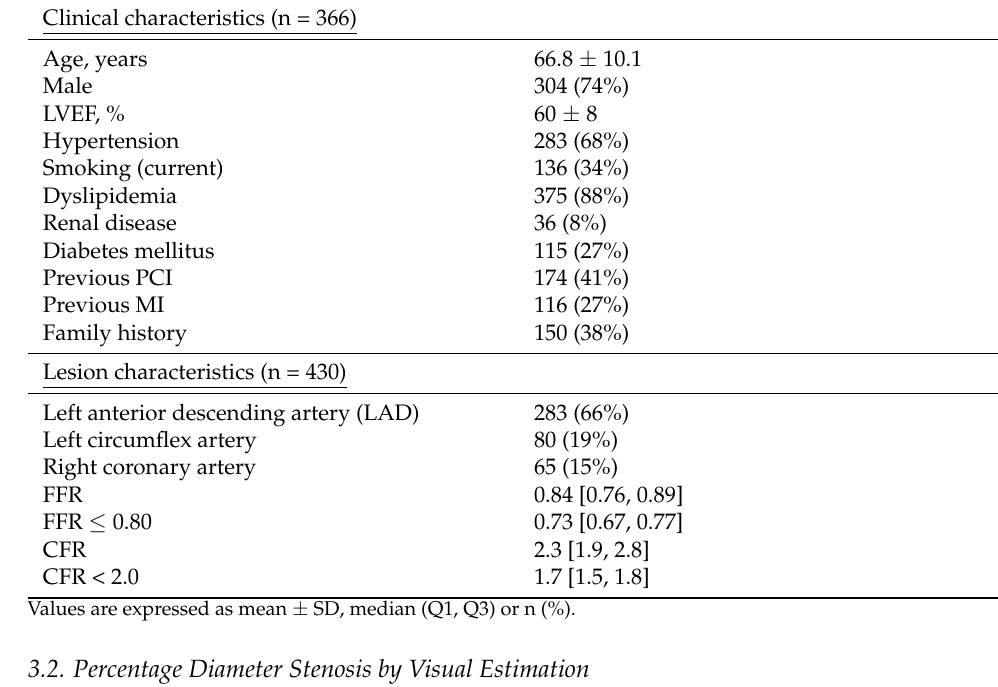
Table 2. Baseline clinical characteristics.